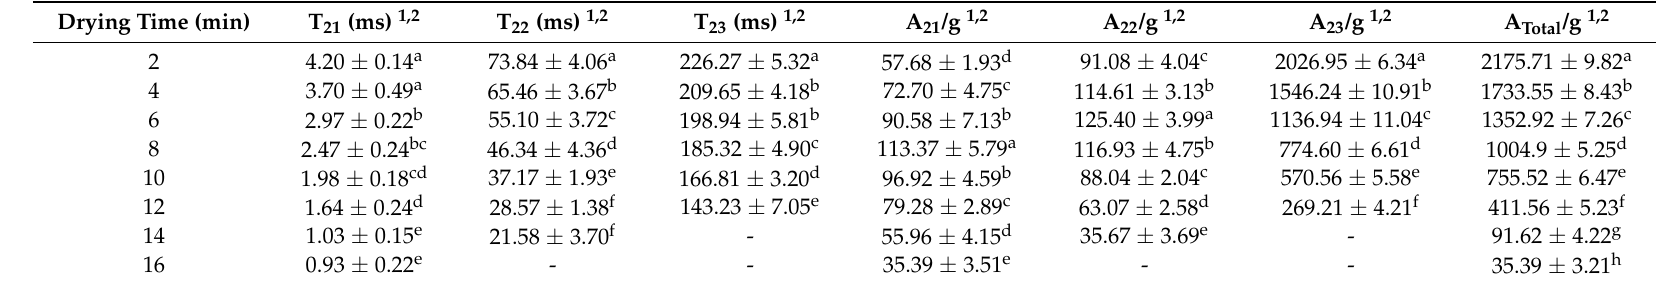
Table 4. Changes in relaxation time and peak area of G. elata dried at 80 ◦ C after